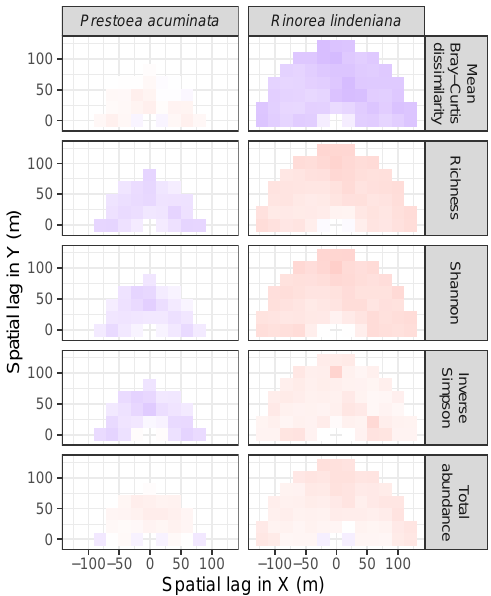
1 (dark − 1 (dark 1 (dark − −